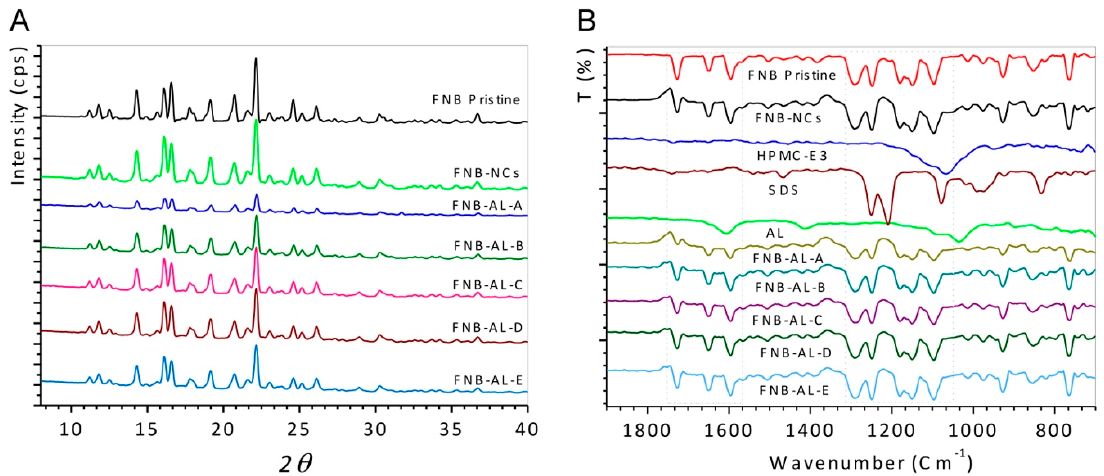
Figure 4. ( A ) X-ray diffraction (XRD) patterns and ( B ) attenuated total reflection Fourier-transform infrared spectroscopy (ATR-FTIR) analysis.